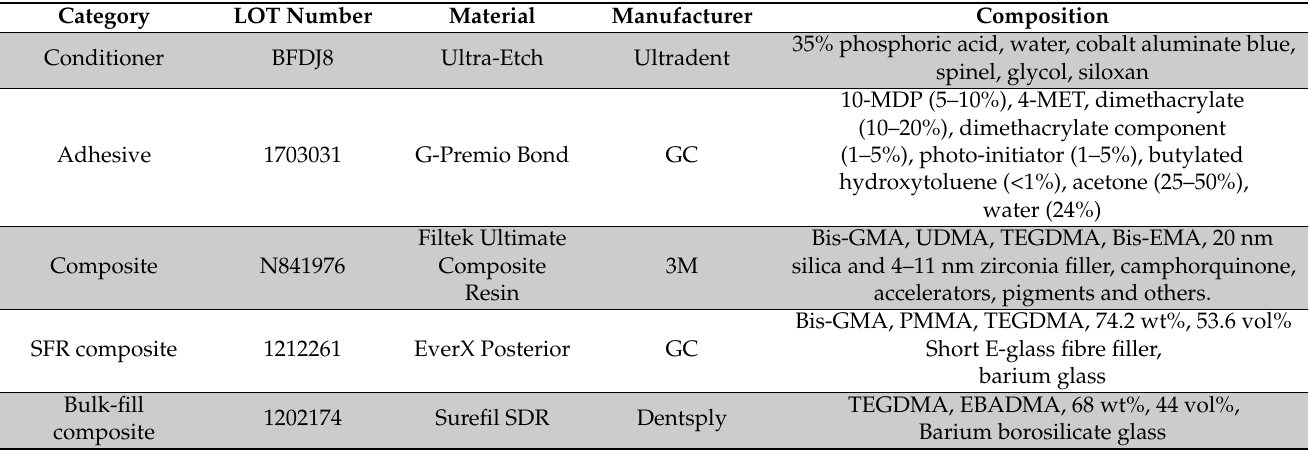
Table 1. Restorative materials used during the